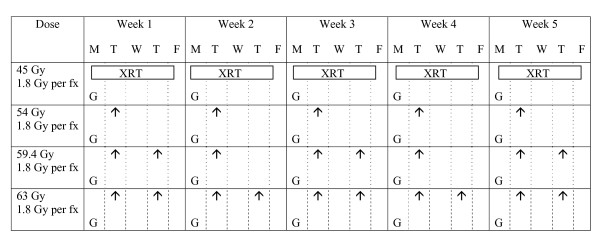
Treatment scheme: different RT dose levels to be investigated. Radiotherapy dose escalation scheme investigated in this phase I trial; gemcitabine (G) was administered on day 1 of week 1, 2, 3, 4 and 5 in a single dose of 300 mg/m2 as a 30-min IV infusion at least one hour prior to RT; the starting dose of RT was 45 Gy in 25 fractions of 1.8 Gy per day (XRT); dose escalation was achieved by giving 2 fractions of 1.8 Gy per day on a fixed day, with an interfraction interval of at least 6 hours, an arrow indicates an extra fraction of 1.8 Gy on that day; the escalating dose levels tested were: 54 Gy, 59.4 Gy and 63 Gy; the total duration of the RT was kept on 5 weeks.